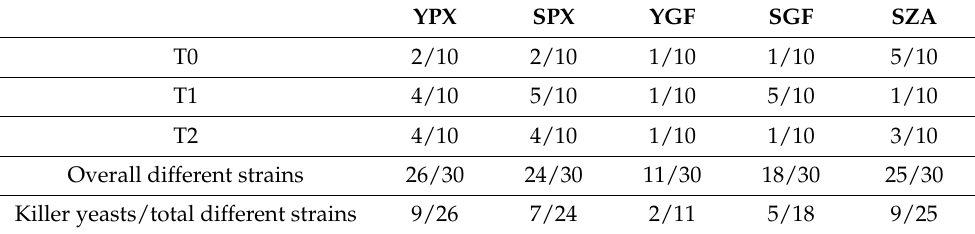
Table 1. Fraction of killer strains over strains analysed in milled grapes (T0), during tumultuous fermentation (T1) and at the end of this phase (T2) at the indicated vineyard (Y: Yeguas and S: Serrana) and grape varieties (PX: Pedro Ximenez, GF: Garrido Fino and ZA: Zalema). As some strains appeared more than once, overall fraction of unique strains (as defined by showing different microsatellite patterns), and the fraction of killer yeasts among these different strains are also indicated.